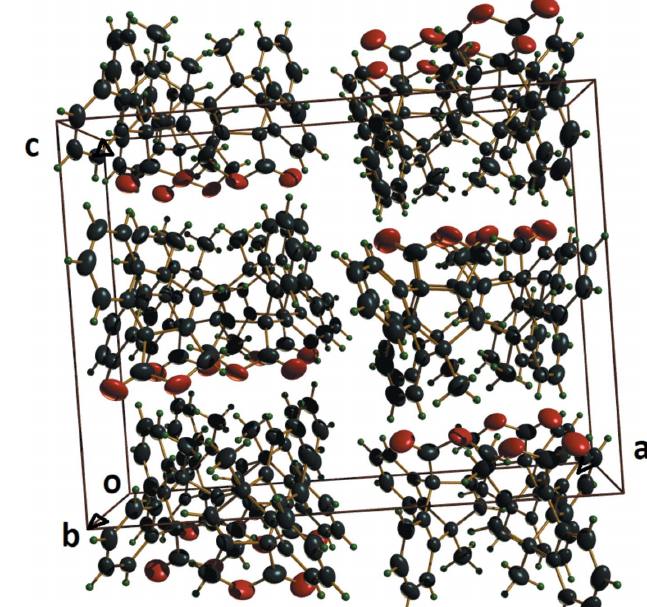
Figure 2 The (cid:2) – (cid:2) (blue) and C—H (cid:3)(cid:3)(cid:3) (cid:2) (brown) interactions present in the title compound.